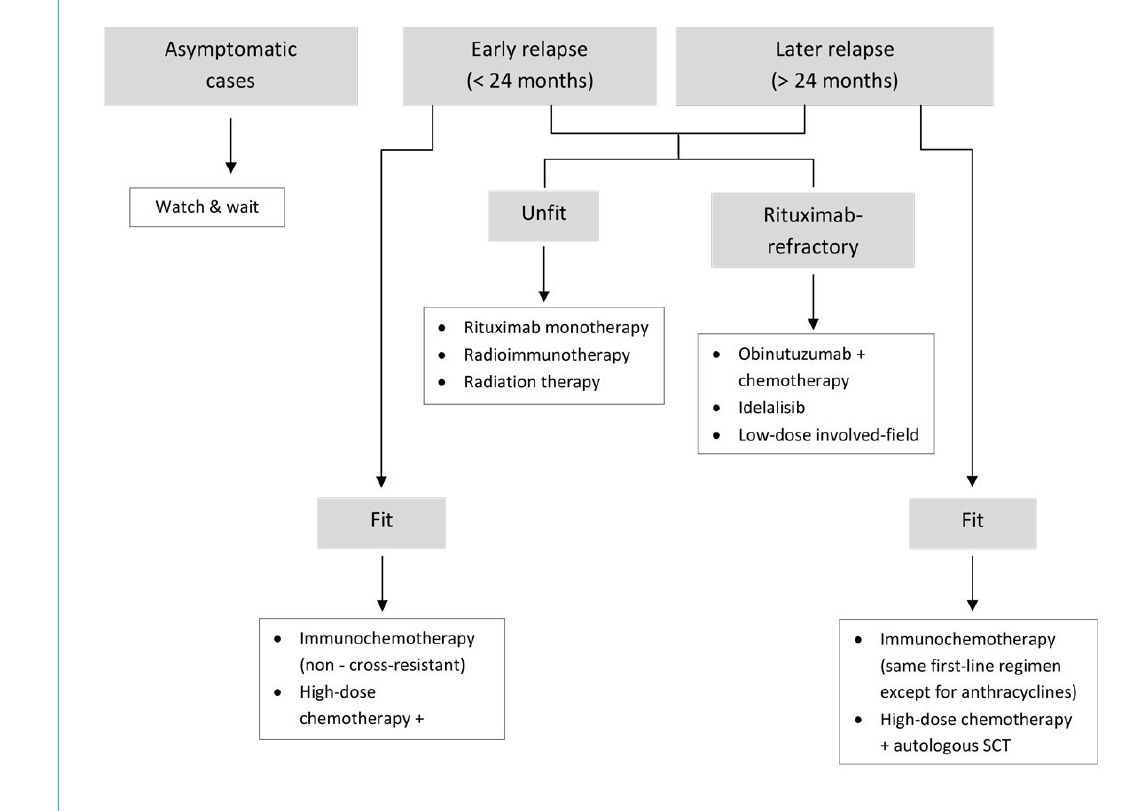
Figure 3: Algorithm for the treatment of relapsed/refractory follicular lymphoma. SCT = stem cell